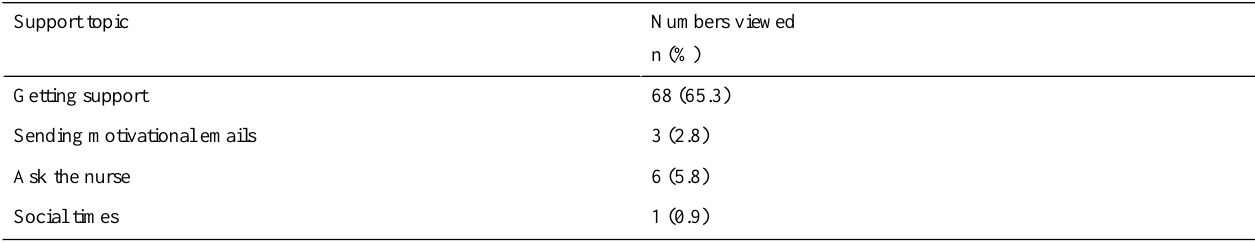
Table 6. Numbers of participants who reused the support tools.